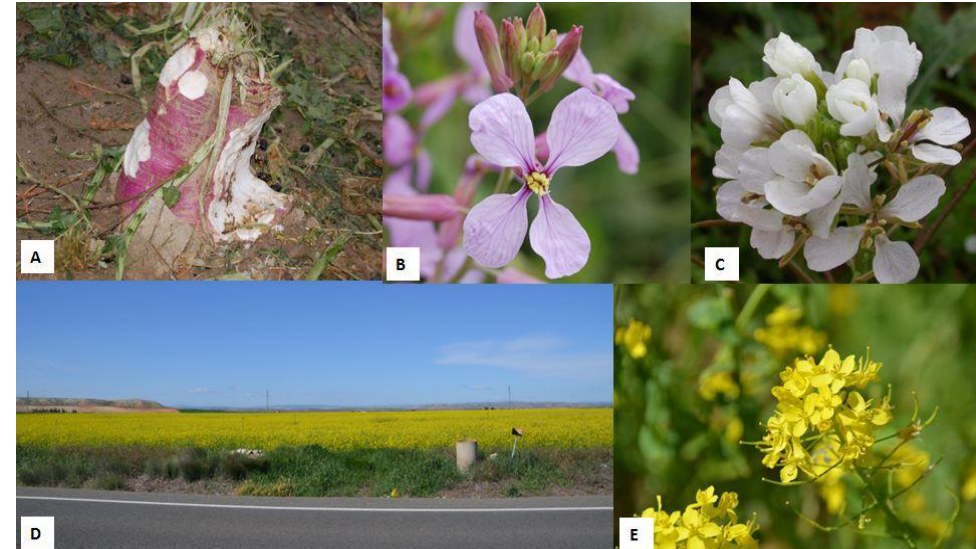
Figure 3. Some plants of the family Brasicaceae . ( A ) Turnip ( Brassica rapa L. subsp . rapa ) grazed by sheep as evidenced by the presence of faeces. ( B ) Detail of the flower of purple mistress ( Moricandia arvensis ). ( C ) Detail of the flower of white rocket ( Diplotaxis erucoides ). ( D ) A typical image of a canola/rapeseed ( Brassica napus ) field. ( E ) Detail of a cluster of flowers of canola plant. ( B. napus ).